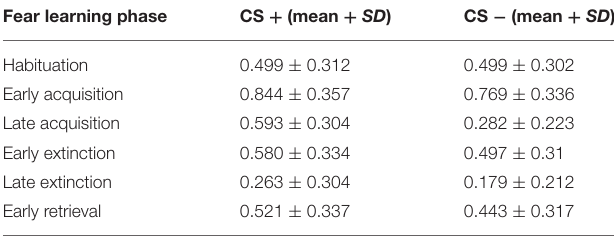
TABLE 1 | Skin conductance